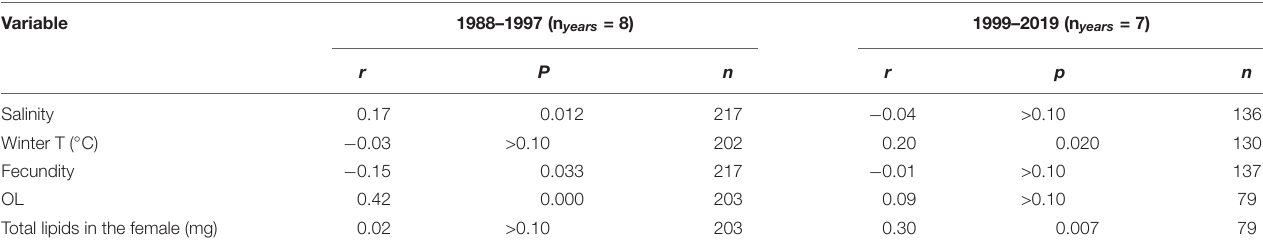
TABLE 3 | Correlations between the egg lipid content ( µ g/egg) and abiotic factors (salinity and winter temperature) and different female traits during the periods of declining (1988–1997) and stable salinity (1999–2019) in the northern Baltic Sea.